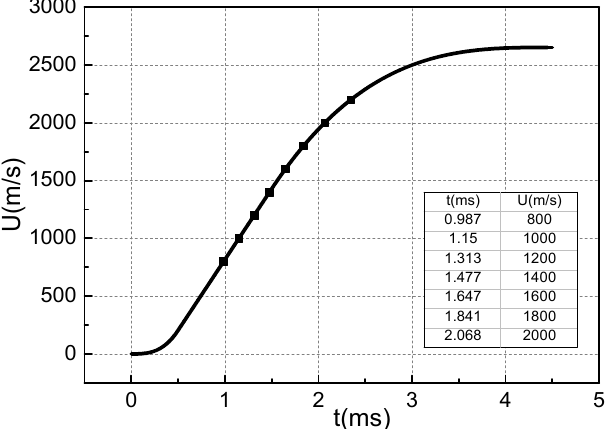
Figure 11. Armature velocity curve at full current stage.